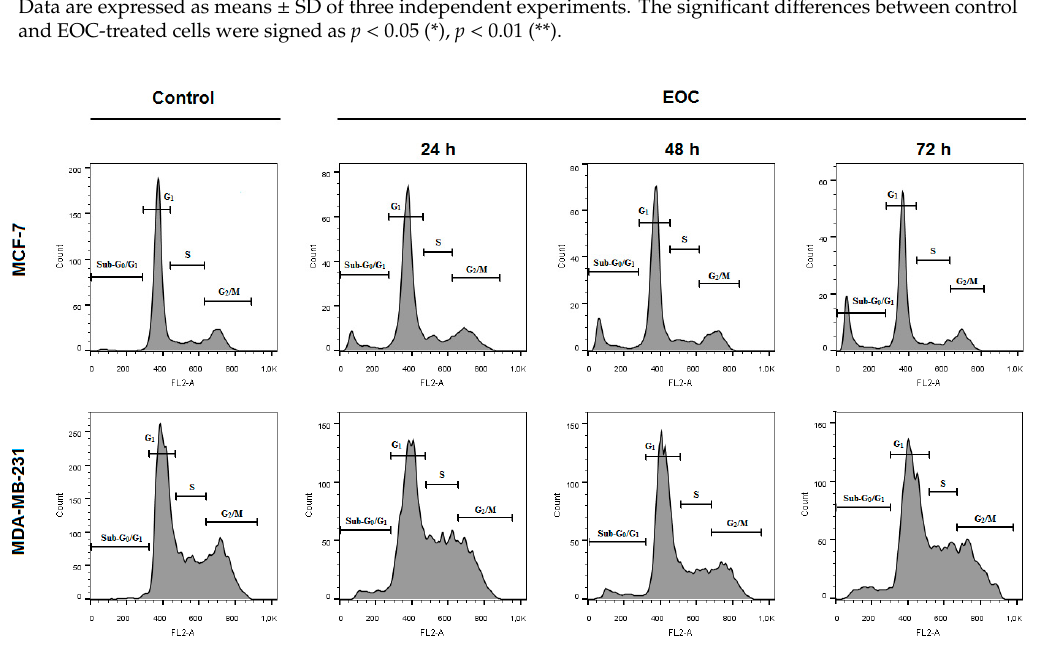
Figure 9. Relative survival of MCF-7 ( A ) and MDA-MB-231 ( B ) cells treated with EOC (1:1250- 1:40,000/160,000) and analyzed by MTS and BrdU incorporation assays. Data were obtained from three independent experiments and significant differences were marked as p < 0.05 (*), p < 0.01 (**), p < 0.001 (***) vs. control cells (untreated).